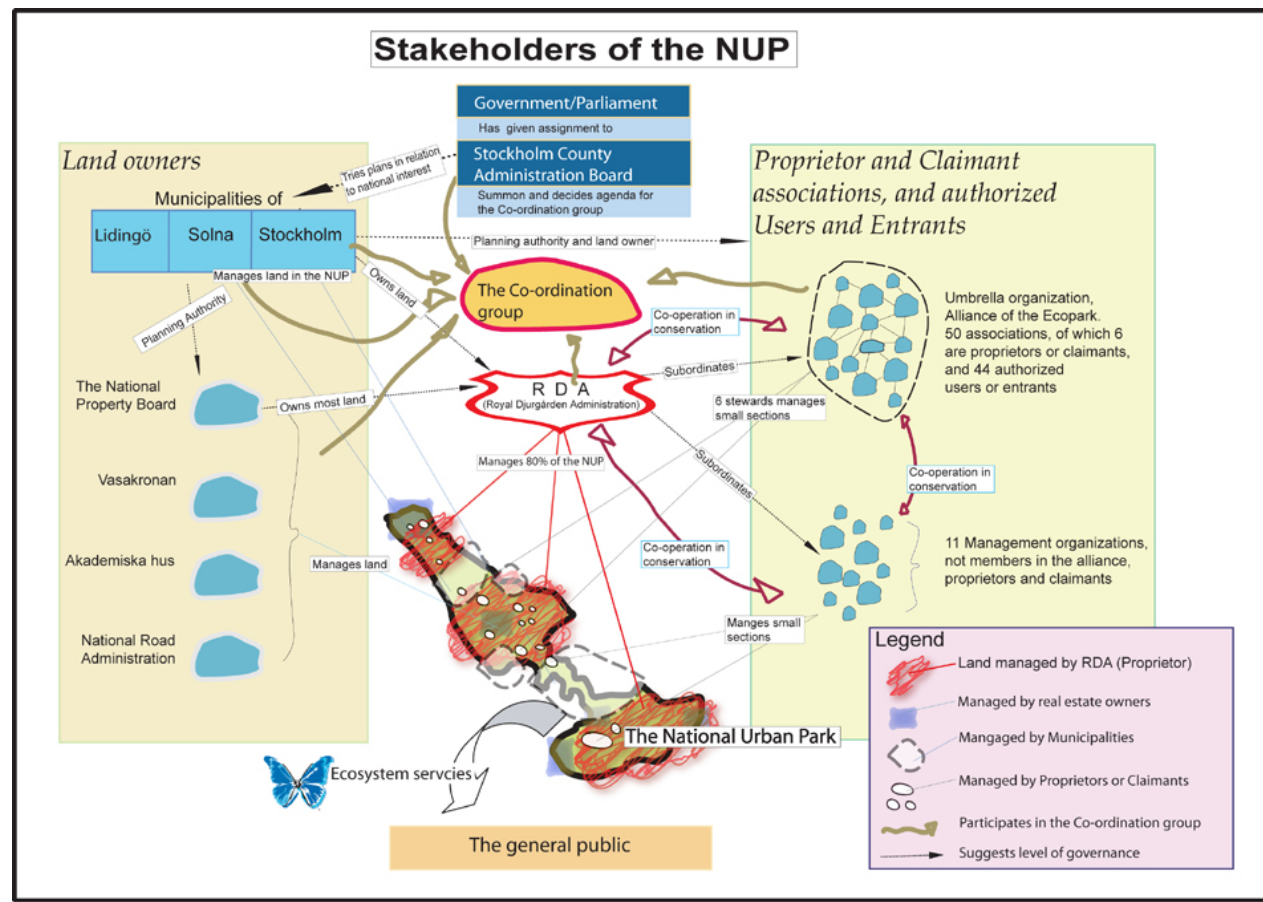
Fig. 5 . The governance system of the National Urban Park, including stewards and stewardship associations with different operational property